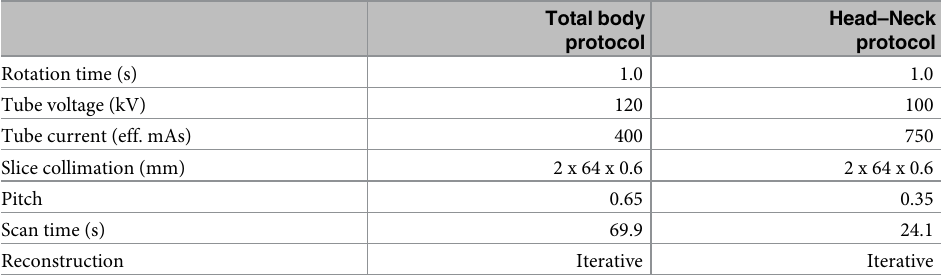
Table 2. Postmortem CT